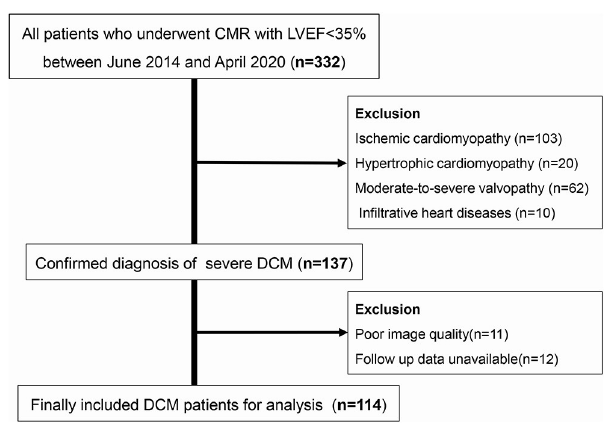
FIGURE 2 | Flowchart of patients